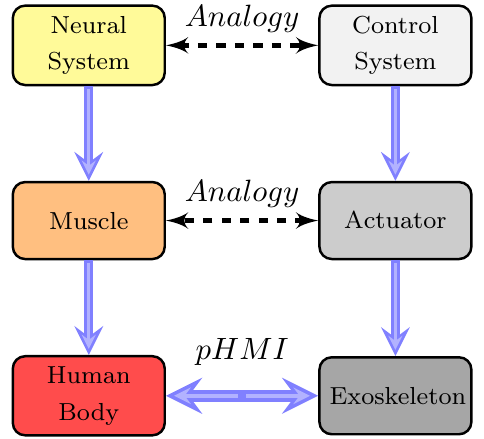
Figure 1. Abstract analogy between the human and the exoskeleton. The control system can be seen as a high-level neural system of the exoskeleton. According to the high-level control signal, the actuator can drive the exoskeleton mechanical structure. Thus, to obtain an input to the controller, the human intention is interpreted from the physical human–machine interaction (pHMI) between the pilot and the